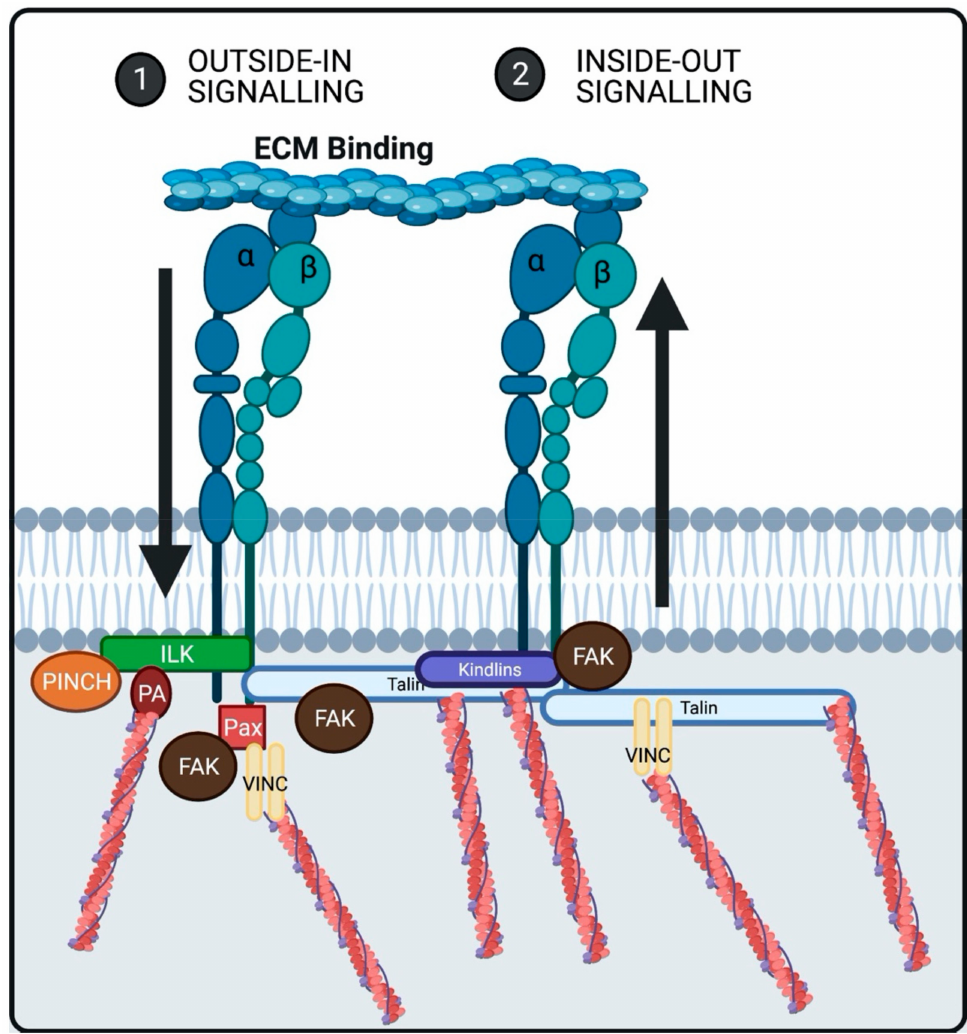
Figure 3. Integrins bind with the ECM followed by the binding of integrin associated proteins such as Talin, Kindlins, Paxillin (Pax), Focal adhesion Kinase (FAK) and Integrin Linked Kinase (ILK). Where the activation of Talin results in binding of the actin cytoskeleton directly or via vinculin (VINC) as well as, the activation of other Integrins through co-operation with Kindlin’s (Inside-out). Moreover, Talin binding results in the activation of FAK Paxillin binding to integrin results in FAK activation and actin binding via VINC. ILK binding to integrin results in cytoskeleton binding through Parvin (PA). Finally, FAK activation can occur via direct binding to